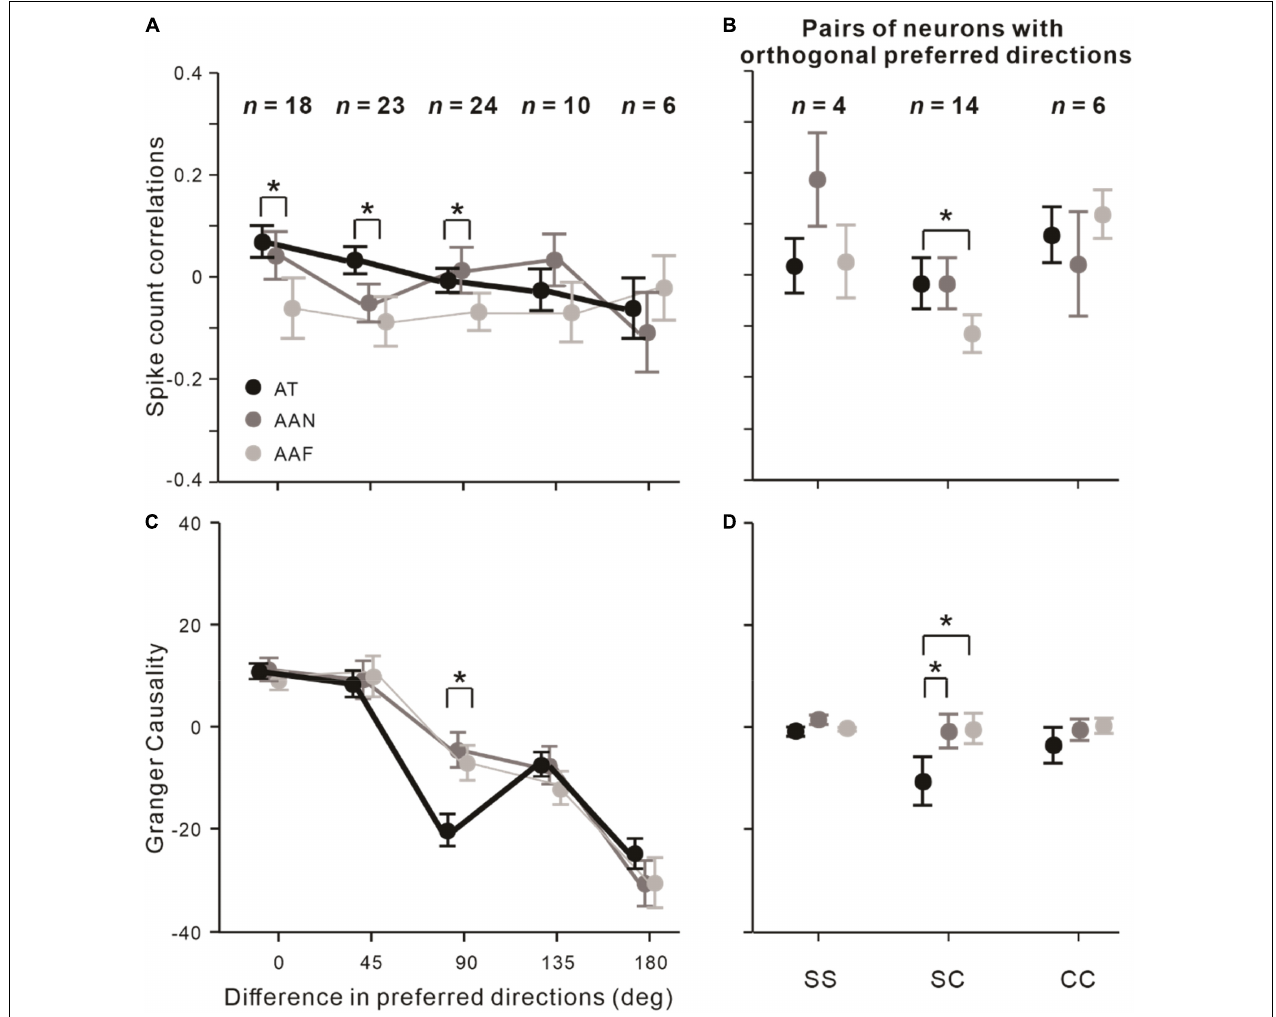
FIGURE 4 | Effects of preferred directions differences on attentional modulations of r sc and Granger causality between neuronal pairs. (A) Effects of difference in preferred directions on r sc . (B) r sc among SS, SC, and CC pairs with orthogonal preferred directions ( n = 24). (C,D) Same as (A,B) but analyzed on Granger causality. Error bars represent ± SEM. Repeated-measures ANOVAs and Bonferroni-corrected post hoc analysis, * p <